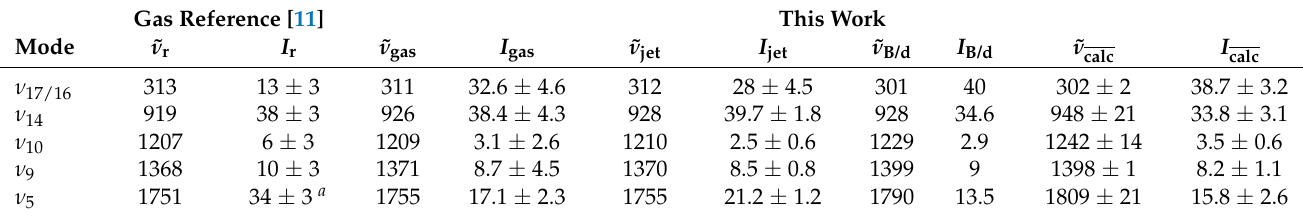
Table 2. Wavenumbers ˜ ν /cm − 1 and relative intensities I (normalised to 100 in sum) of those fundamentals of methyl methanoate, for which reference values are available [11]. Gas phase reference (r) intensities were corrected for different laser excitation wavelength, their statistical error was estimated from the noise level of the reference data. Gas phase data (gas) from Figure 1. Jet data (jet) from Table 1, integrated jet intensities extrapolated from 20–180 K to 298 K. B3LYP/def2-QZVPP (B/d), intensities adjusted for 298 K. Average values (calc) over all computational methods from Table 1, adjusted for 298 K. 1 was a Intensity of overtone at 1710 cm −